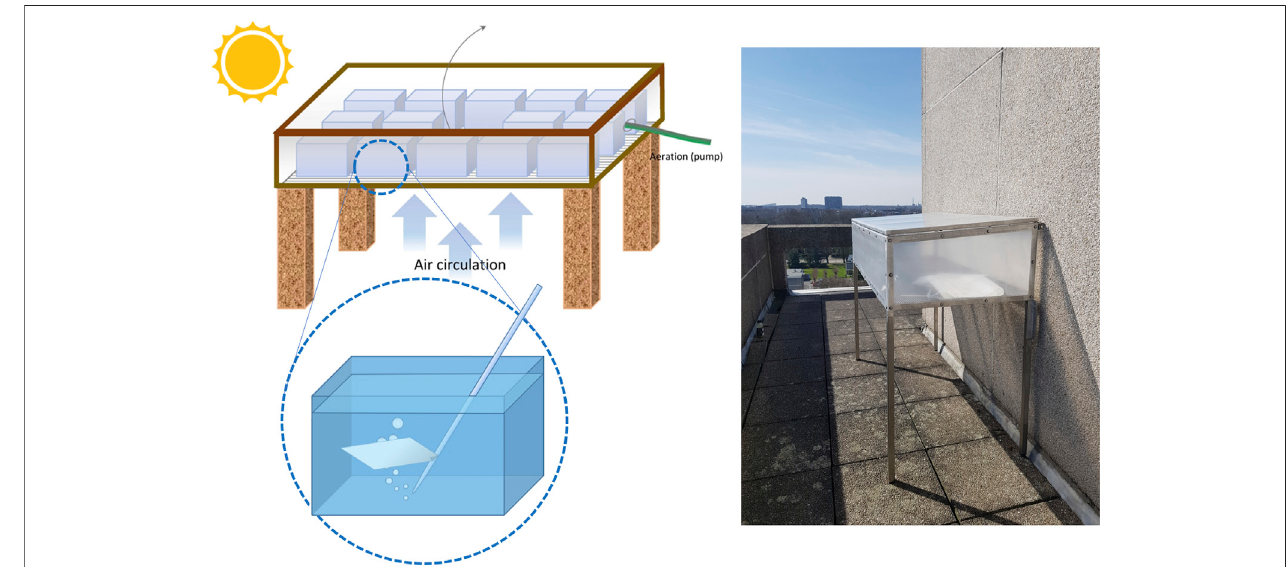
FIGURE1| Experimentalsetup. Onthetop left,diagramofthegreenhouse-table; thetopand sidesaremadeofUV-transparentfoil, andthelidopens upwards as shown bythe arrow. On the bottom left, detailed diagram ofanexperimental vessel with theglass pipette. On the right, picture ofthe setup after installationon the topof the roof, before the experimental vessels were placed inside the